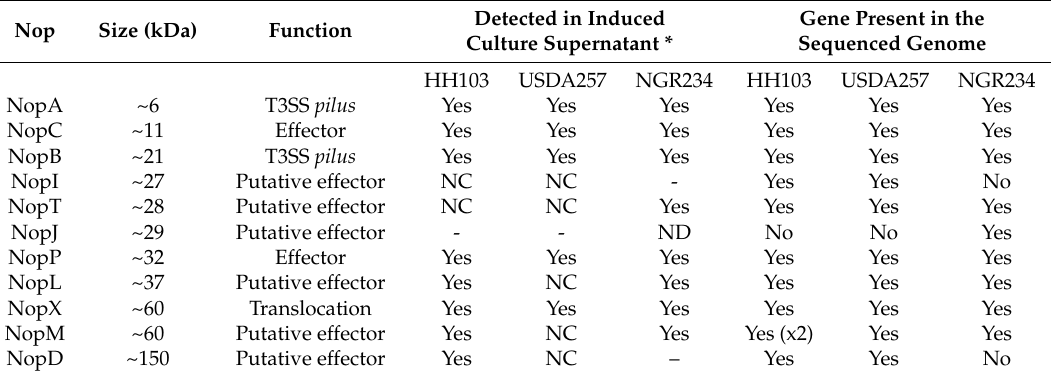
Table 3. Nodulation outer proteins identified in the Sinorhizobium fredii strains HH103, USDA257 and